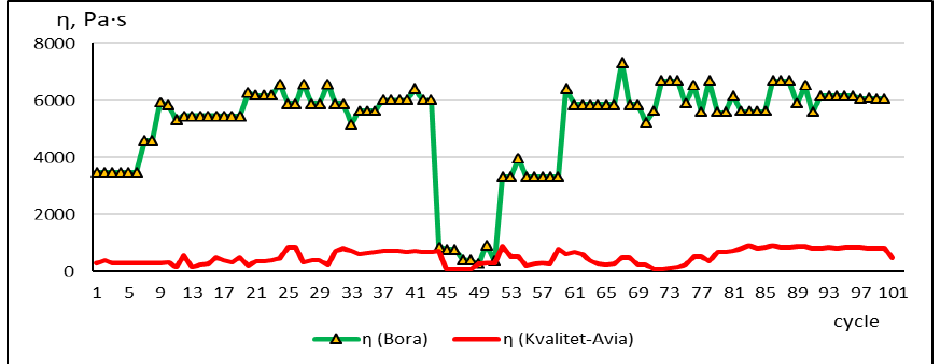
Fig. 4. The kinetics of change in the effective viscosity of oil (η) n the contact